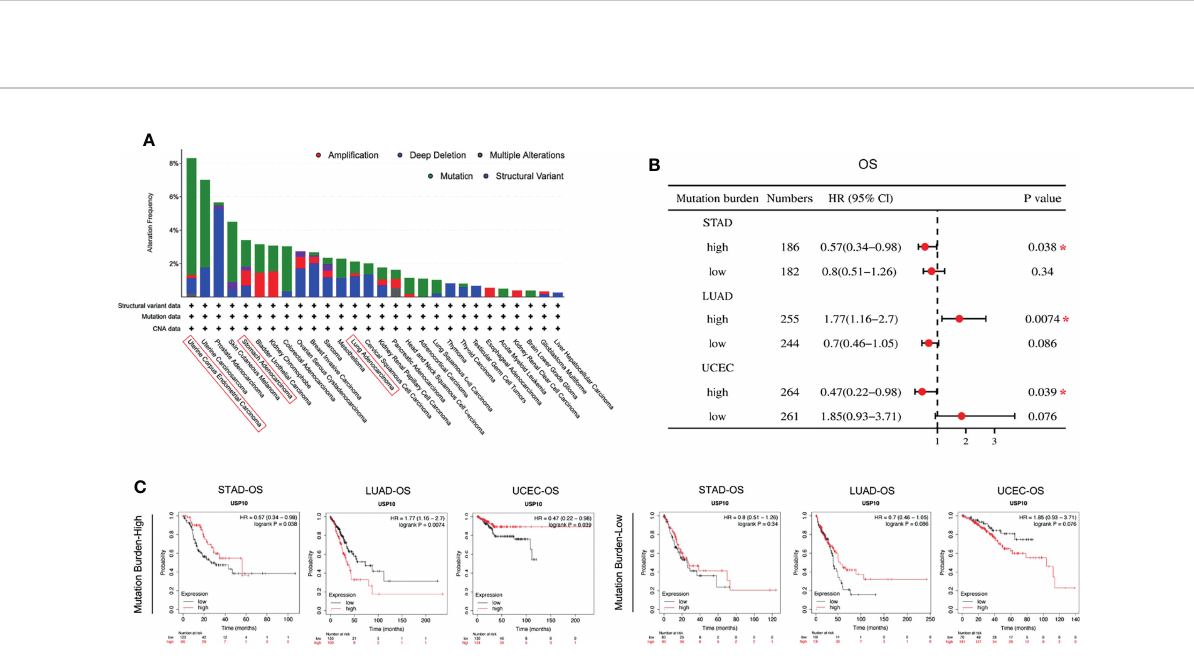
FIGURE 6 | cBioPortal access of TGCA data showing USP10 mutation features in pan-cancer correlation of the TMB and USP10 in Kaplan – Meier Plotter. (A) Mutation type alteration frequencies. (B) The potential associations between the TMB and USP10 expression in the OS of patients with cancer, shown as a forest plot. (C) Survival curves between the TMB and USP10 expression in the OS of patients with cancer. TMB, tumor mutation burden. STAD, stomach adenocarcinoma; LUAD, lung adenocarcinoma; UCEC, uterine corpus endometrial carcinoma. OS, overall survival. * P <